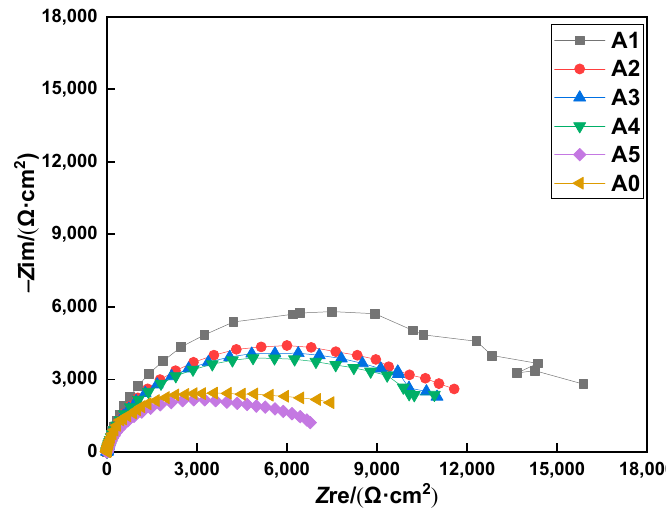
Figure 1. Nyquist plots of the MCIs coated specimens after different degrees of chloride erosion.